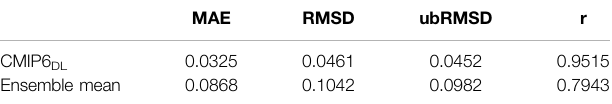
TABLE 2 | MAE, RMSD, ubRMSD, and r (Spatial correlation coef fi cient) of CMIP6 DL and ensemble